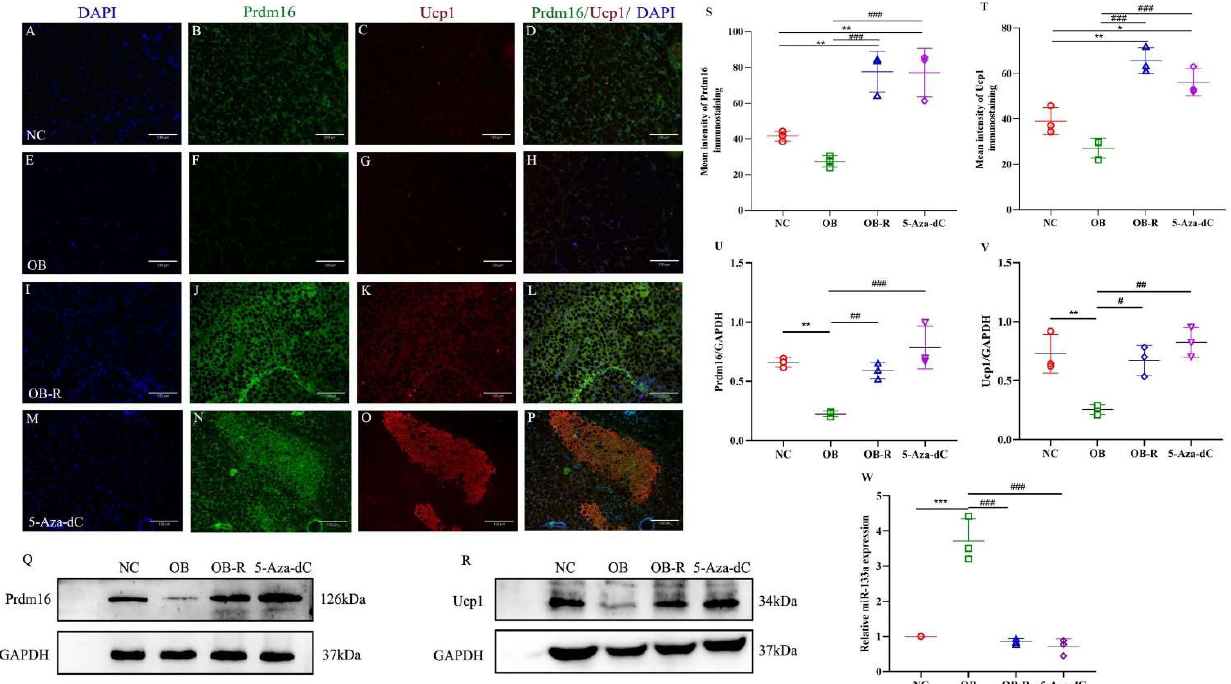
Figure 4. Prdm16, Ucp-1, and miR-133a expression in subcutaneous WAT. ( A – P ) Increased immunoreactivity of Prdm16 (green) and Ucp1 (red) after DNA demethylation (n = 3/group; blue, DAPI). ( Q , R ) Expression of Prdm16 and Ucp1 in subcutaneous WAT using Western blotting. ( S , T ) Quantified changes in Prdm16 and Ucp1 after DNA demethylation (n = 3/group). ( U , V ) Normalized intensity of Prdm16 and Ucp1 relative to GAPDH, presented as the mean ± SD (n= 3/group). ( W ) The expression levels of miR-133a in the subcutaneous WAT of the four groups (n= 3/group). *** p < 0.001; ** p < 0.01; * p < 0.05, compared with controls; # p < 0.05; ## p < 0.001; ### p < 0.001, compared with each other. NC, normal control; OB, MSG-induced obese mice; OB-R, MSG-induced obesity-resistant mice; 5-Aza-dC, 5-aza-2′-deoxycytidine-induced DNA demethylation mice; Prdm16, PR domain containing 16; Ucp-1, uncoupling protein-1; WAT, white adipose tissue.